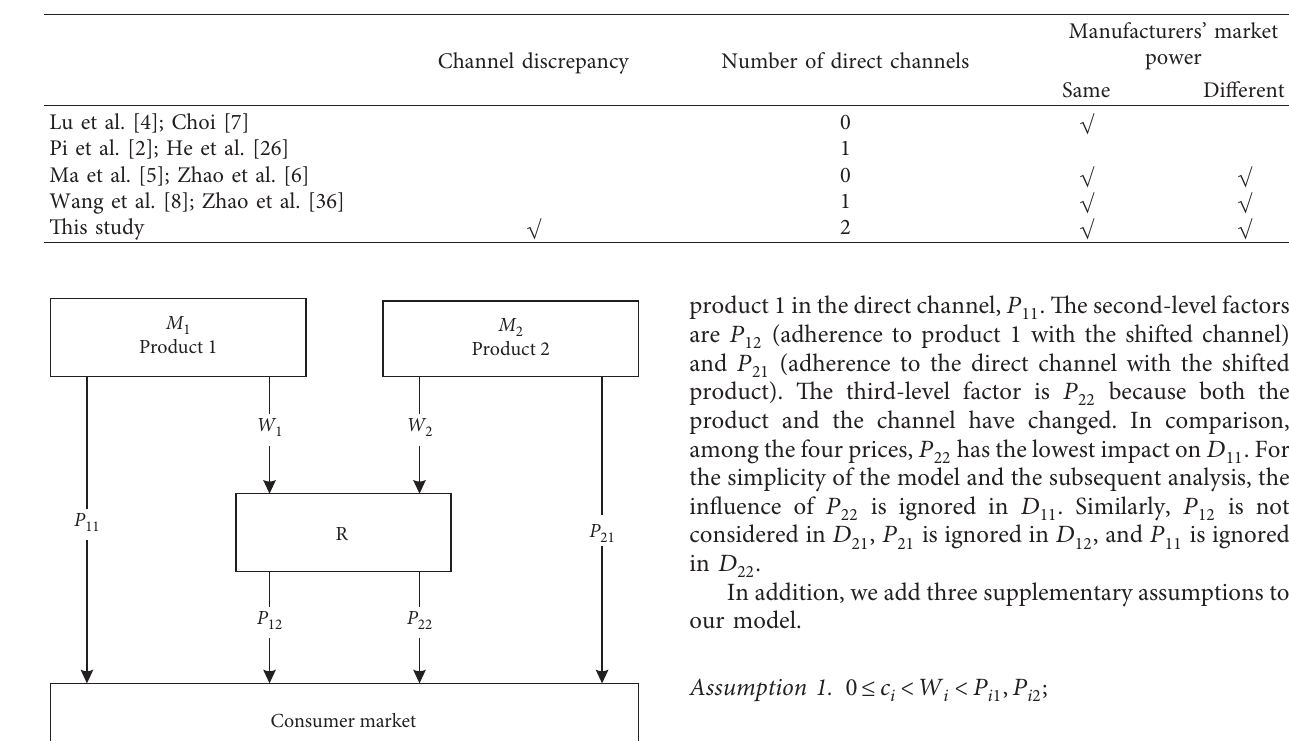
Table 1: Location of our work in the literature.